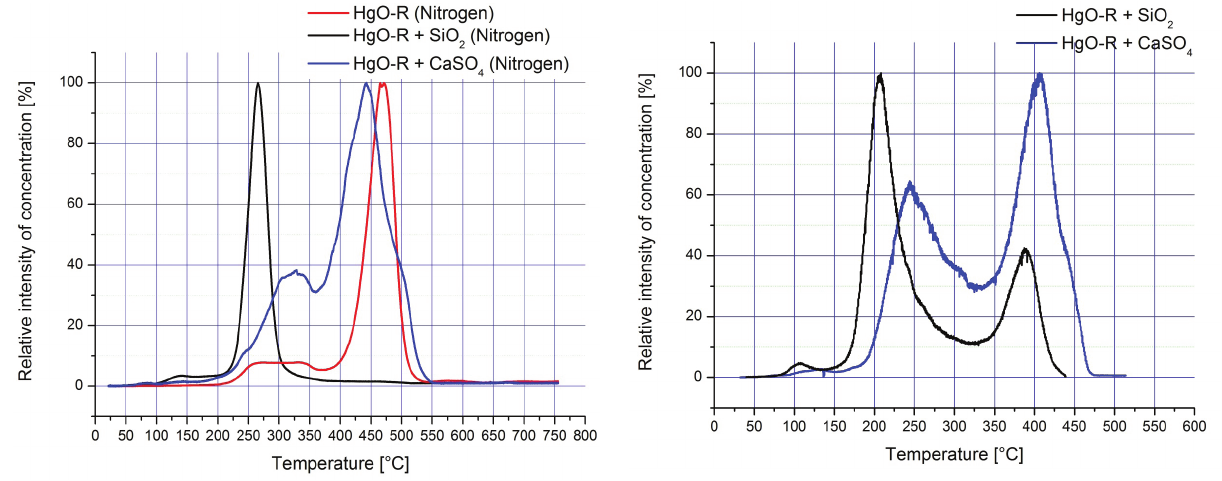
Figure 8: Thermograms of red HgO, purged with nitrogen.